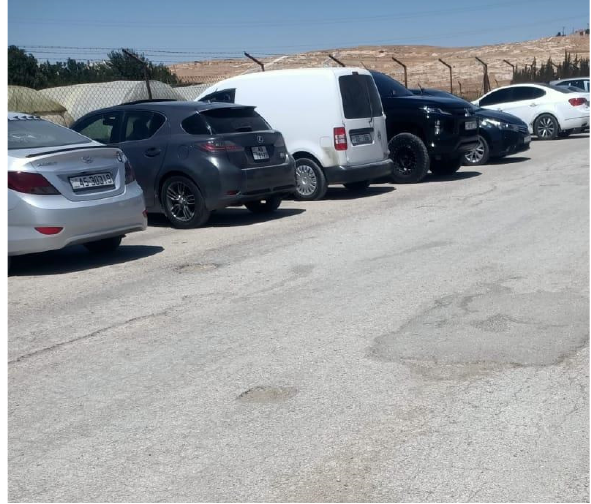
Figure 2. Photos for the case study parking.